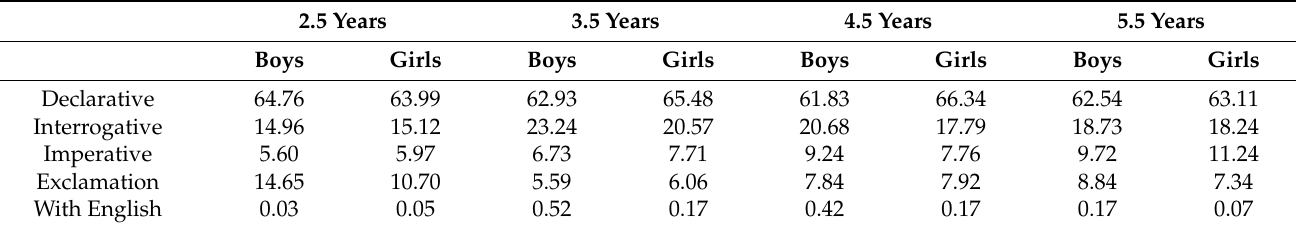
Table 3. Sentence types by gender and age